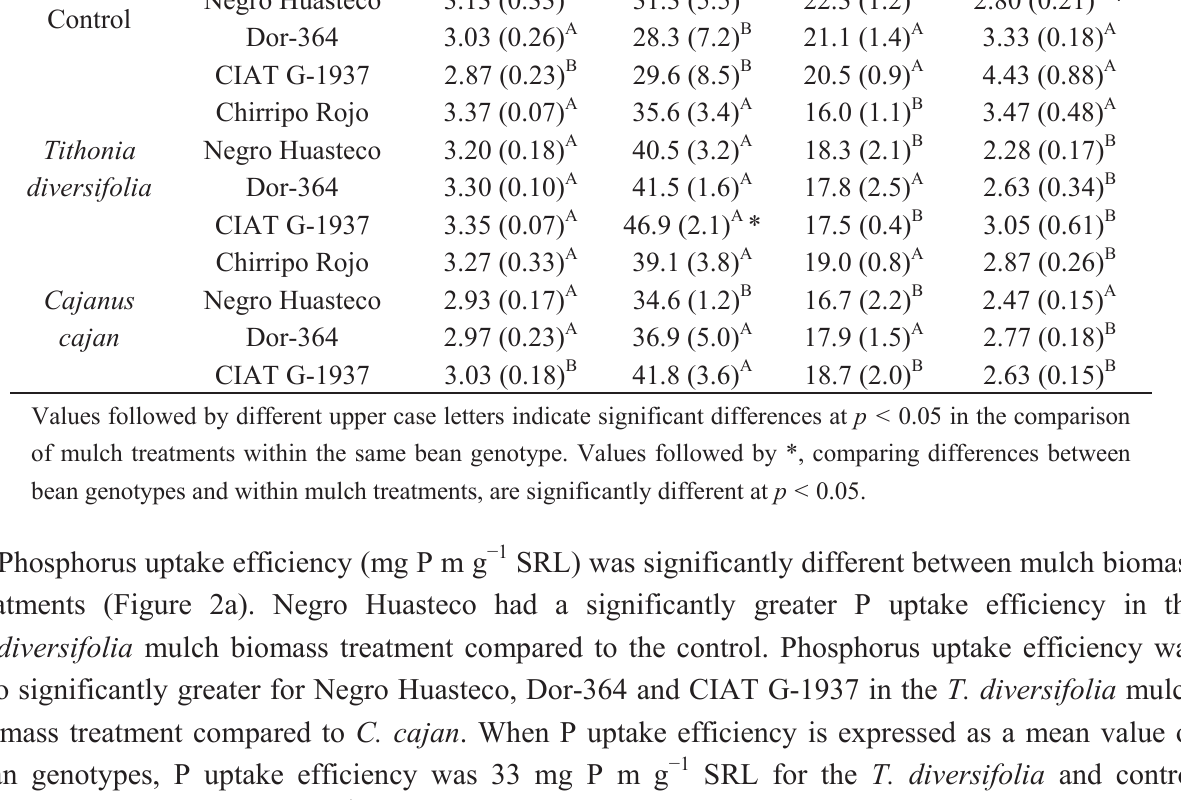
Table 2. Shoot nutrient concentrations (mg g (cid:237) 1 ) of four bean genotypes at the flowering phase in treatments with biomass addition from T. diversifolia or C. cajan or without biomass addition (control) on a Costa Rican Andosol. Standard errors are given in parentheses.